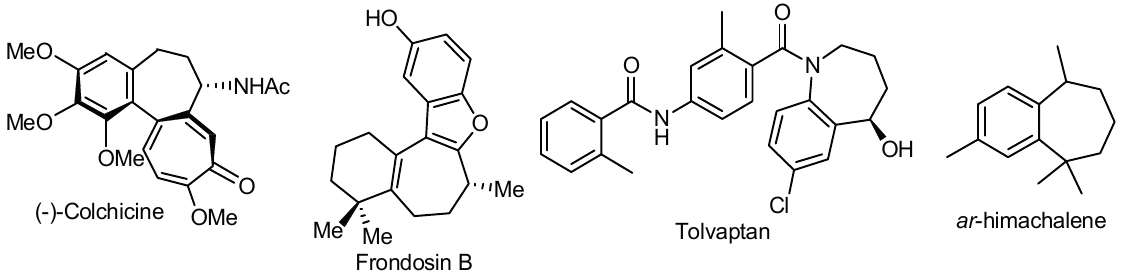
Figure 1. Compounds bearing seven-membered ring fused to aromatic